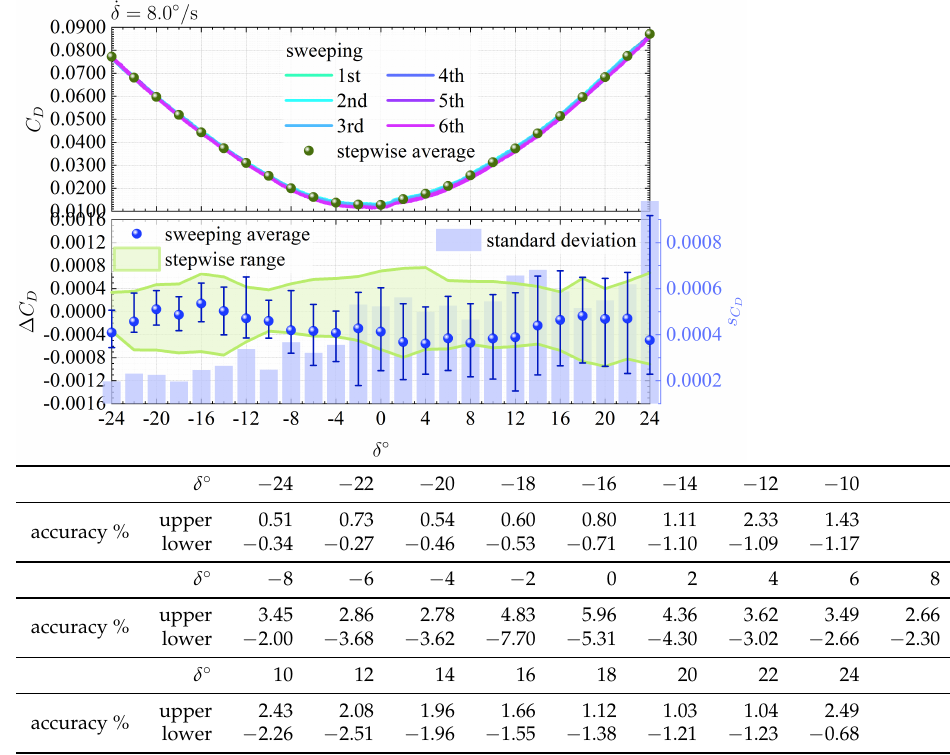
Figure 7. The results from a preliminary attempt in the sweeping mode under the conditions of ˙ δ = 8.0 ◦ /s, U ∞ = 40 m/s, and α = 0 ◦ compared with that in the stepwise mode.